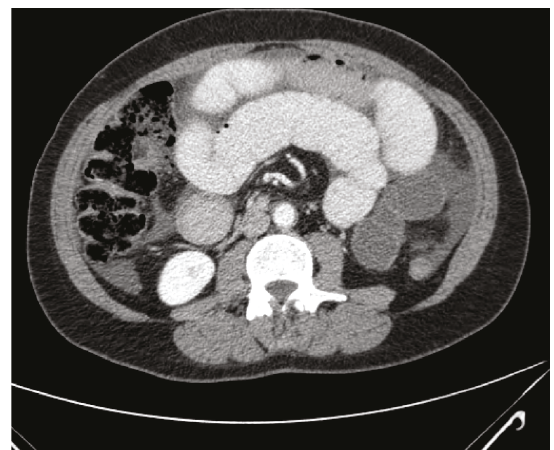
Figure 3: CT of the abdomen. Distended loops of small intestine in the right and left upper and middle quadrants, consistent with small-bowel obstruction. There is an associated moderate volume of interloop ascites within the small-bowel mesentery.